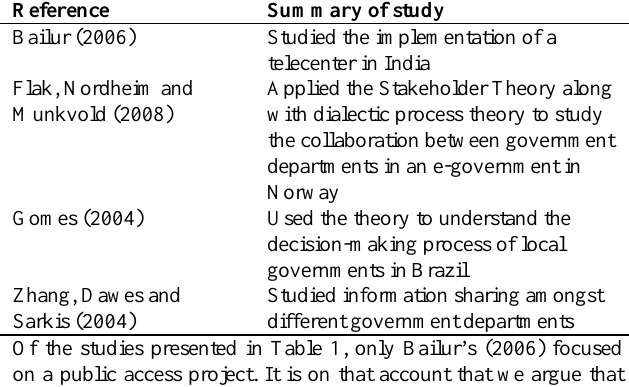
Table 1: Summary of studies using the